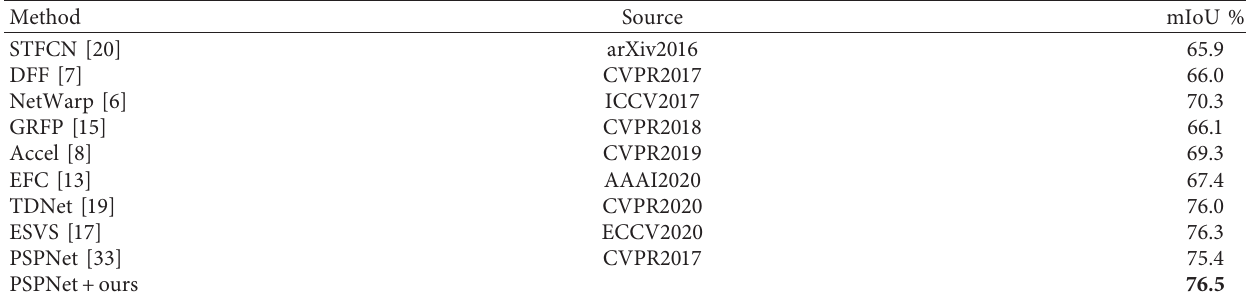
Table 7: Comparison of state-of-the-art semantic video segmentation models on the CamVid test